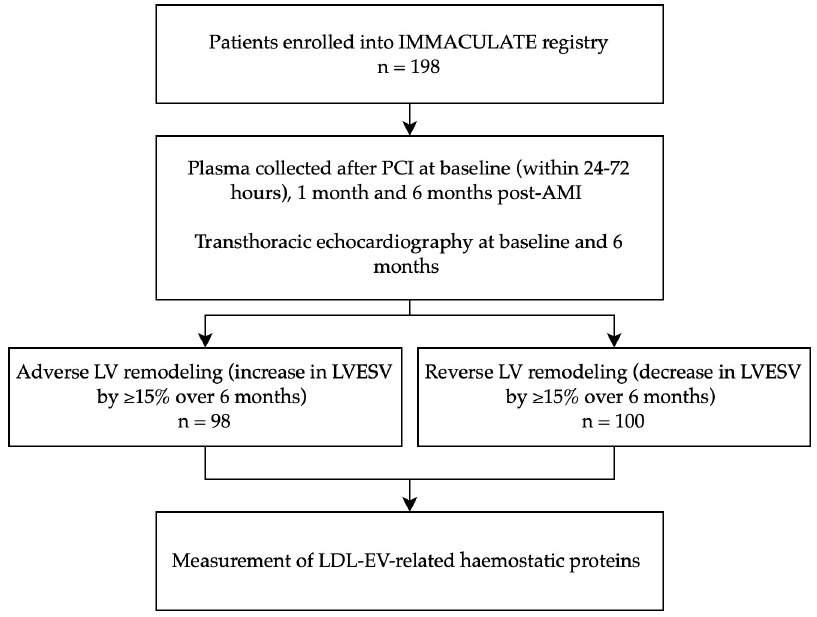
Figure 1. Study design flowchart . Abbreviations: PCI, percutaneous coronary intervention; LVESV, left ventricular end systolic volume.